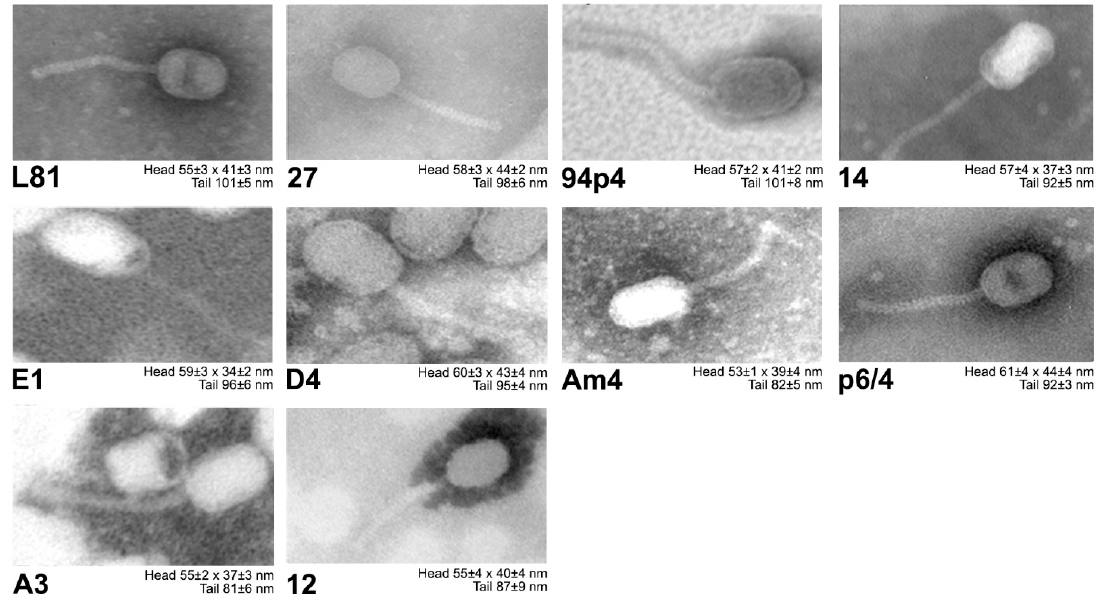
Figure 2. Visualization of the Lactococcus Ceduovirus phages using electron microscopy. Head diameter and tail size ± SD given under each electron micrograph were calculated using measure IT 5.0 (Olympus Soft Imaging Solutions GmbH) software as a mean from n = 5–10 phages.